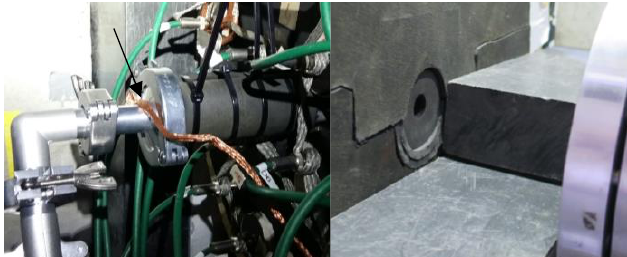
Fig. 4. Right: view of the front side of LOENIEv2 with a collimator aperture of 12 mm in diameter. One can see a part of the shielding wall made of borated polyethylene bricks. Left: view of the rear side of LOENIEv2 with a cylindrical shielding (5 mm of borated rubber) added for the 233 U campaign around the central tubing. The beam stop is placed in the iso-KF flange (see the